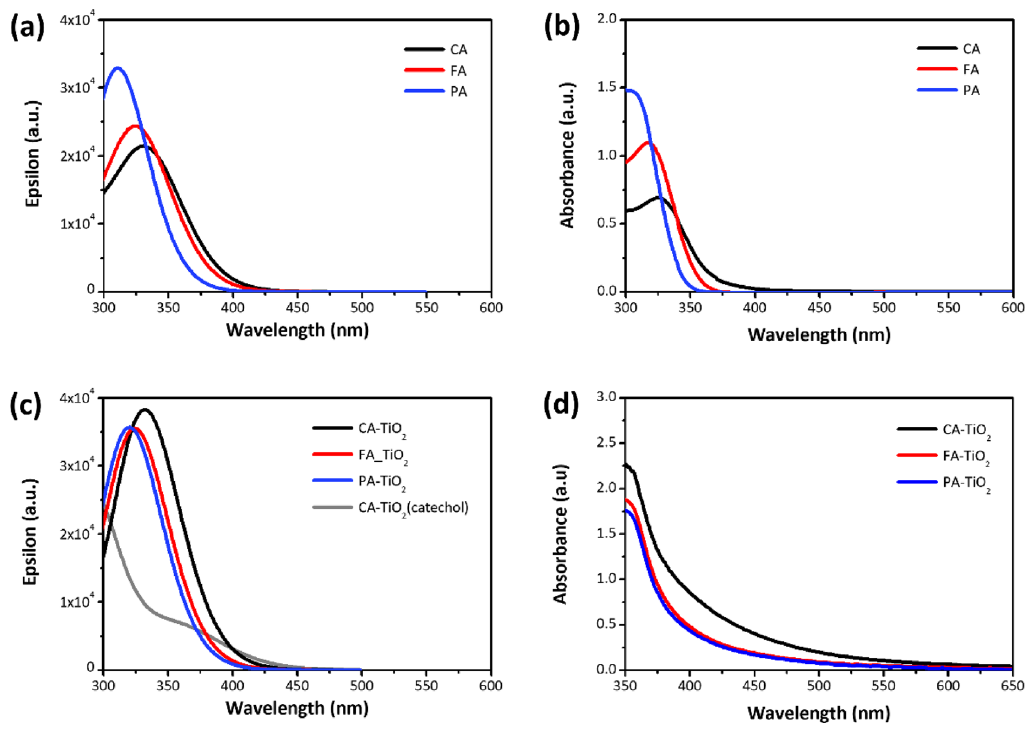
Figure 2. Calculated UV–visible spectra of ( a ) HCAs and ( c ) HCA-TiO 2 complexes and experimental UV– visible spectra of ( b ) HCAs and ( d ) HCA-grafted mesoporous TiO 2 films.